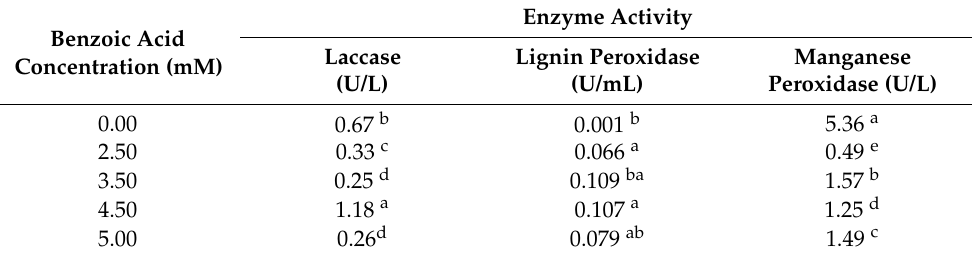
Table 2. Production of ligninolytic enzymes by G. boninense under the influence of benzoic